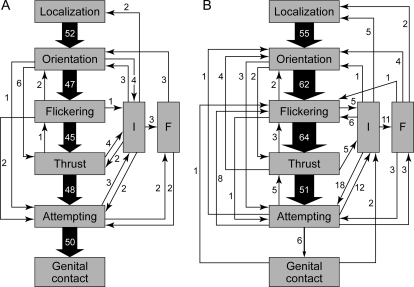
Kinetic diagram of courtship behaviour based on 50 successful (A) and 50 unsuccessful (B) courtships.For each behavioural step (in boxes), the frequency of transitions to other courtship steps is indicated by an arrow and by adjacent figures giving the number of each type of transition (from [52]). Interruptions of the general behavioural sequence are noted by “I”. “Following” of a female by the male during courtship, noted as “F”, involved in 80% of the cases short flights. In (B), courtship stopped at the flickering (6 cases), thrust (9 cases), attempting (32 cases), genital contact (2 cases) or “F” (1 case) steps.